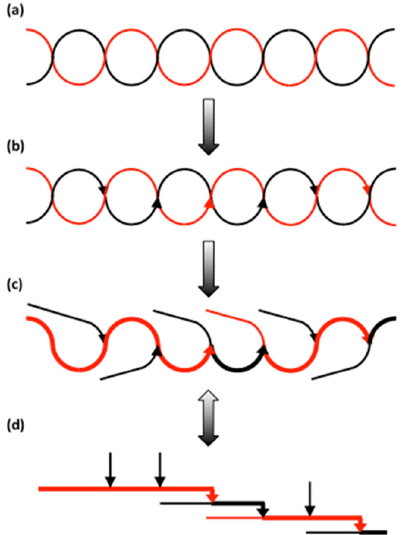
Figure 6. Possible formation of the backbone from a double-helix precursor based on the suggestion by Borovsky et al. [271]. ( a ) A double-helix formed by two polyglucan chains (black and red). ( b ) Branches (arrows) inserted in the double-helix by starch branching enzyme. ( c ) The same structure as in ( b ) but with the external chains (thin lines) extending out from the former double-helix. The chain segments forming a backbone are shown as bold lines. ( d ) The same structure as in ( c ) drawn as a laminated amylopectin model originally proposed by Haworth et al. in 1937 [272].